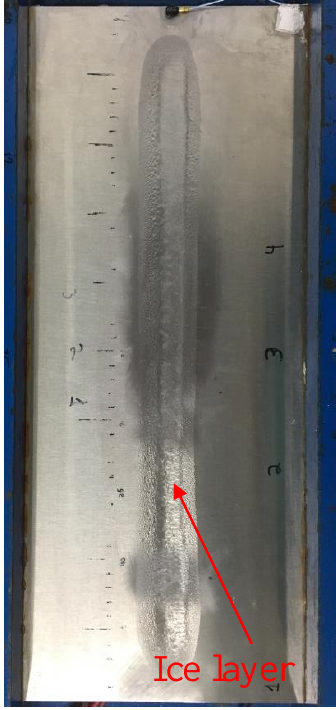
Figure 8. Ice layer accumulated on the flat plate setup.